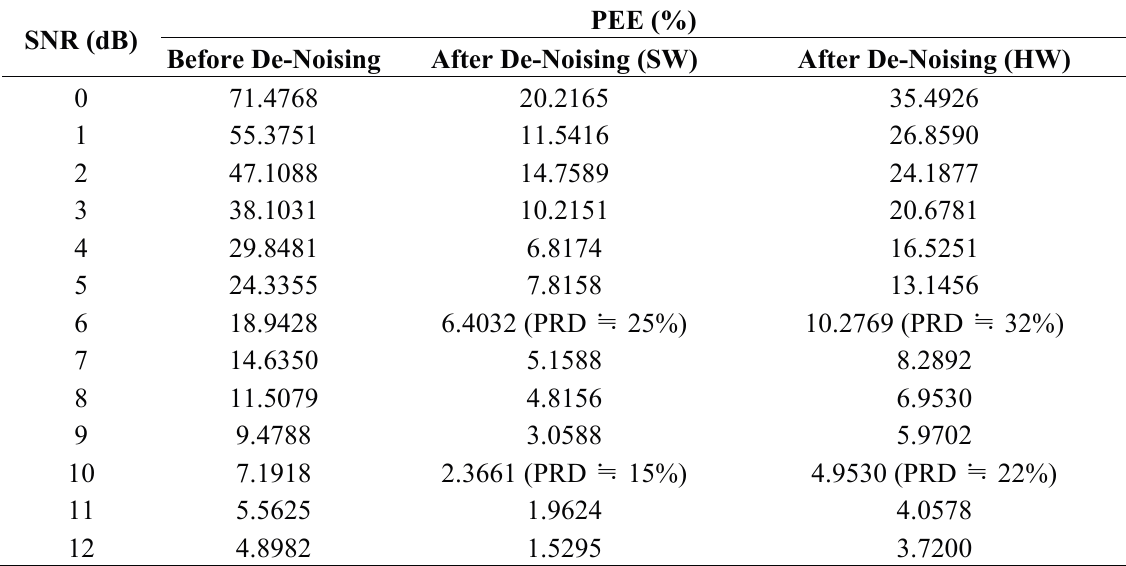
Table 1. SNR versus the PEE values obtained before applying wavelet de-noising,